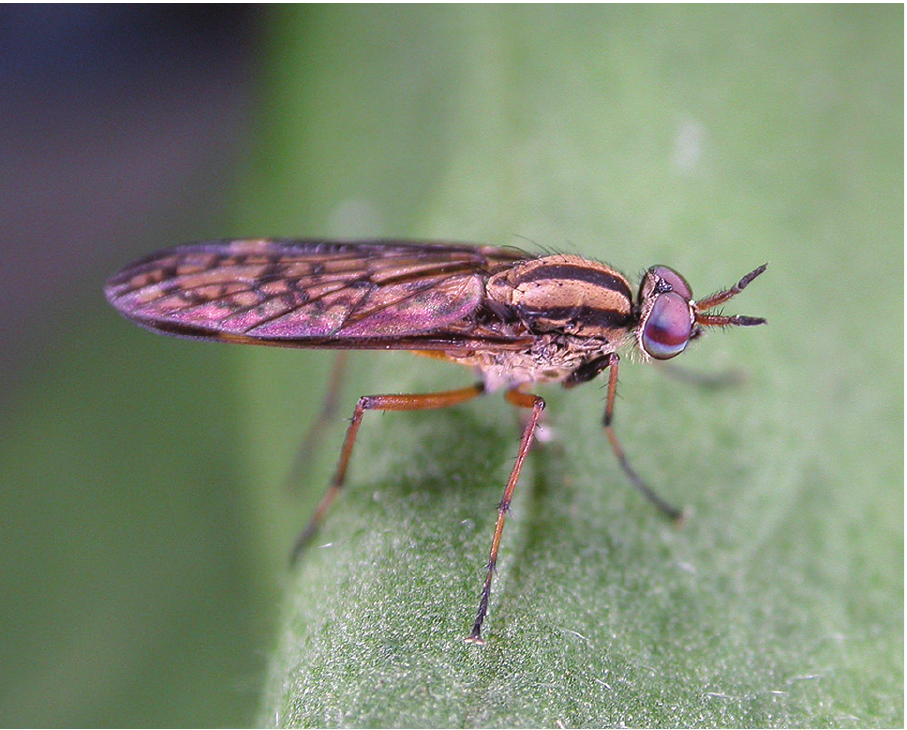
Figure 3. Adult male Zelothrix yeatesi sp. n.; Warrumbungle National Park, New South Wales. (Photo credit: Shaun L.